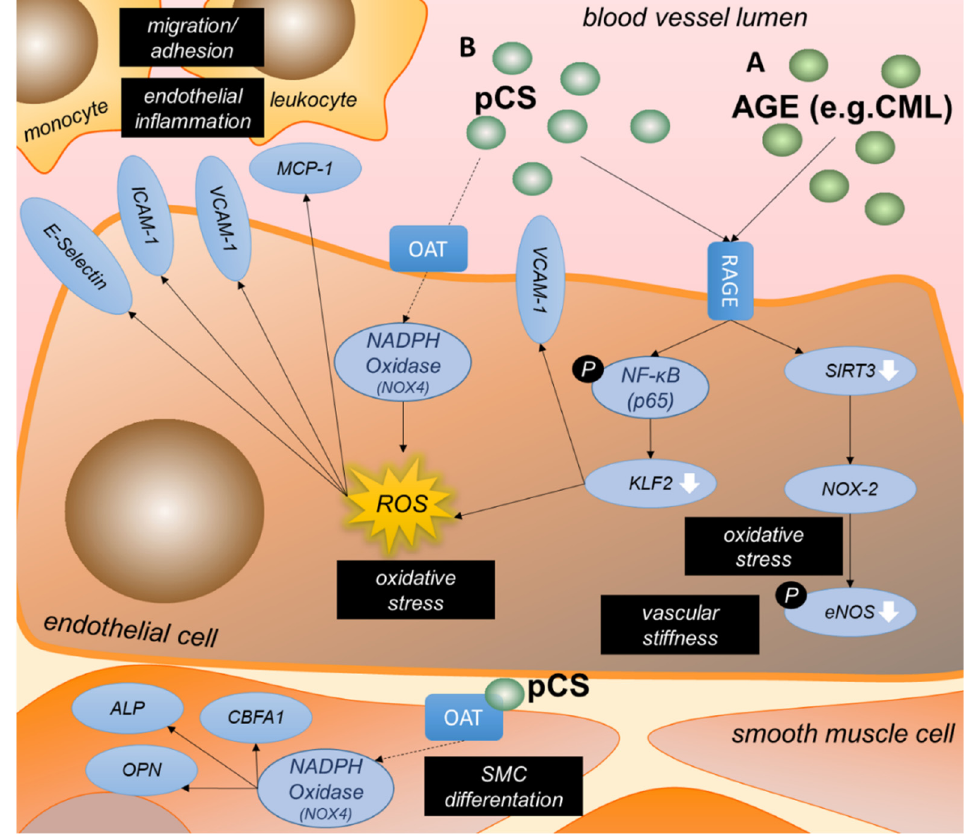
Figure 5. Mechanisms underlying p-cresyl sulfate or AGE-induced endothelial dysfunction. By activating RAGE, AGEs mediate oxidative stress and reduce vasoreactivity by decreasing eNOS activation in endothelial cells. Further, AGEs as well as p-cresyl sulfate increase ROS generation via KLF2. ROS increase endothelial inflammation by enhancing surface expression of chemokines (e.g., MCP-1) and surface adhesion proteins (e.g., VCAM-1, ICAM-1, E-Selectin), triggering leukocyte recruitment and binding ( A ). Cellular uptake of p-cresyl sulfate by endothelial cells as well as SMCs takes place via organic anion transporters. This results in the activation of NADPH oxidase NOX-4, leading to the differentiation of SMCs and ROS generation in endothelial cells ( B ). ALP = alkaline phosphatase; CBFA = core-binding factor alpha; eNOS = endothelial nitric oxide synthase; ICAM = intracellular adhesion molecule; KLF = krüppel-like factor; MCP = monocyte chemoattractant protein; NADPH = nicotinamide adenine dinucleotide phosphate; NF- κ B = nuclear factor kappa B; OAT = organic anion transporters; OPN = osteopontin; ROS = reactive oxygen species; SIRT = sirtuin; NOX = NADPH oxidase; SMC = smooth muscle cell; VCAM = vascular cell adhesion molecule.